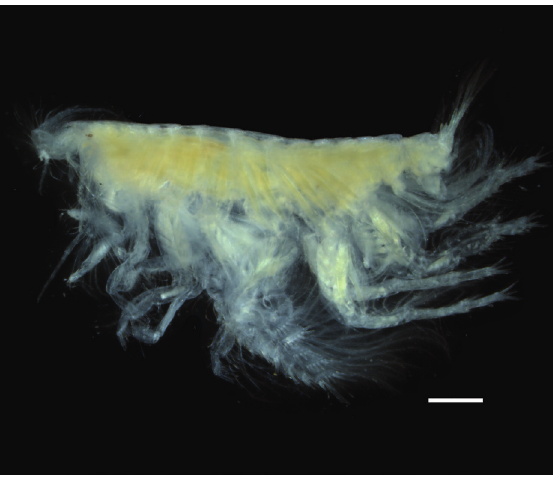
Figure 8 - Puelche irenae sp. nov. Female, MNRJ 28984: Habitus. Scale = 0.5